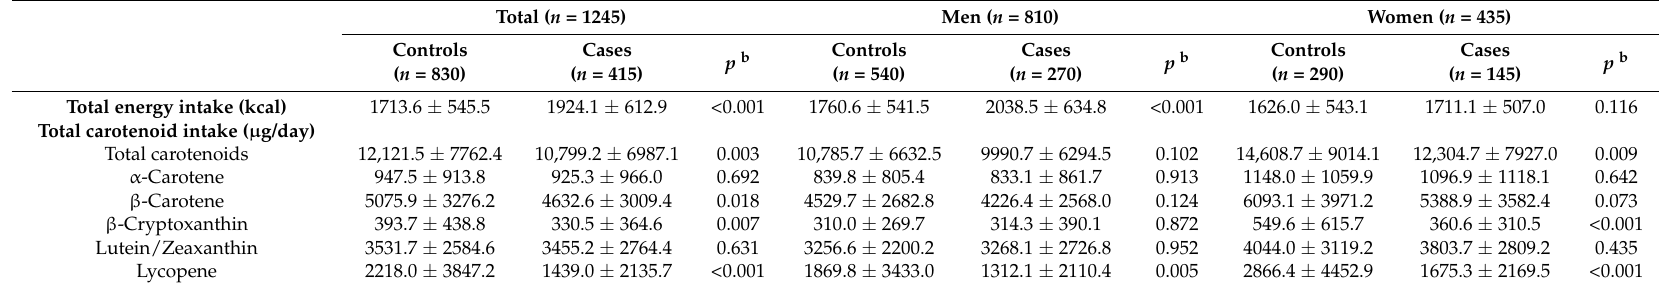
Table 2. Comparison of the consumption of total energy, total dietary carotenoids, and carotenoid subclasses a